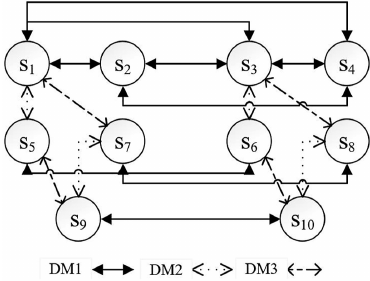
Table 1. The feasible states in the conflict of discharging of nuclear wastewater